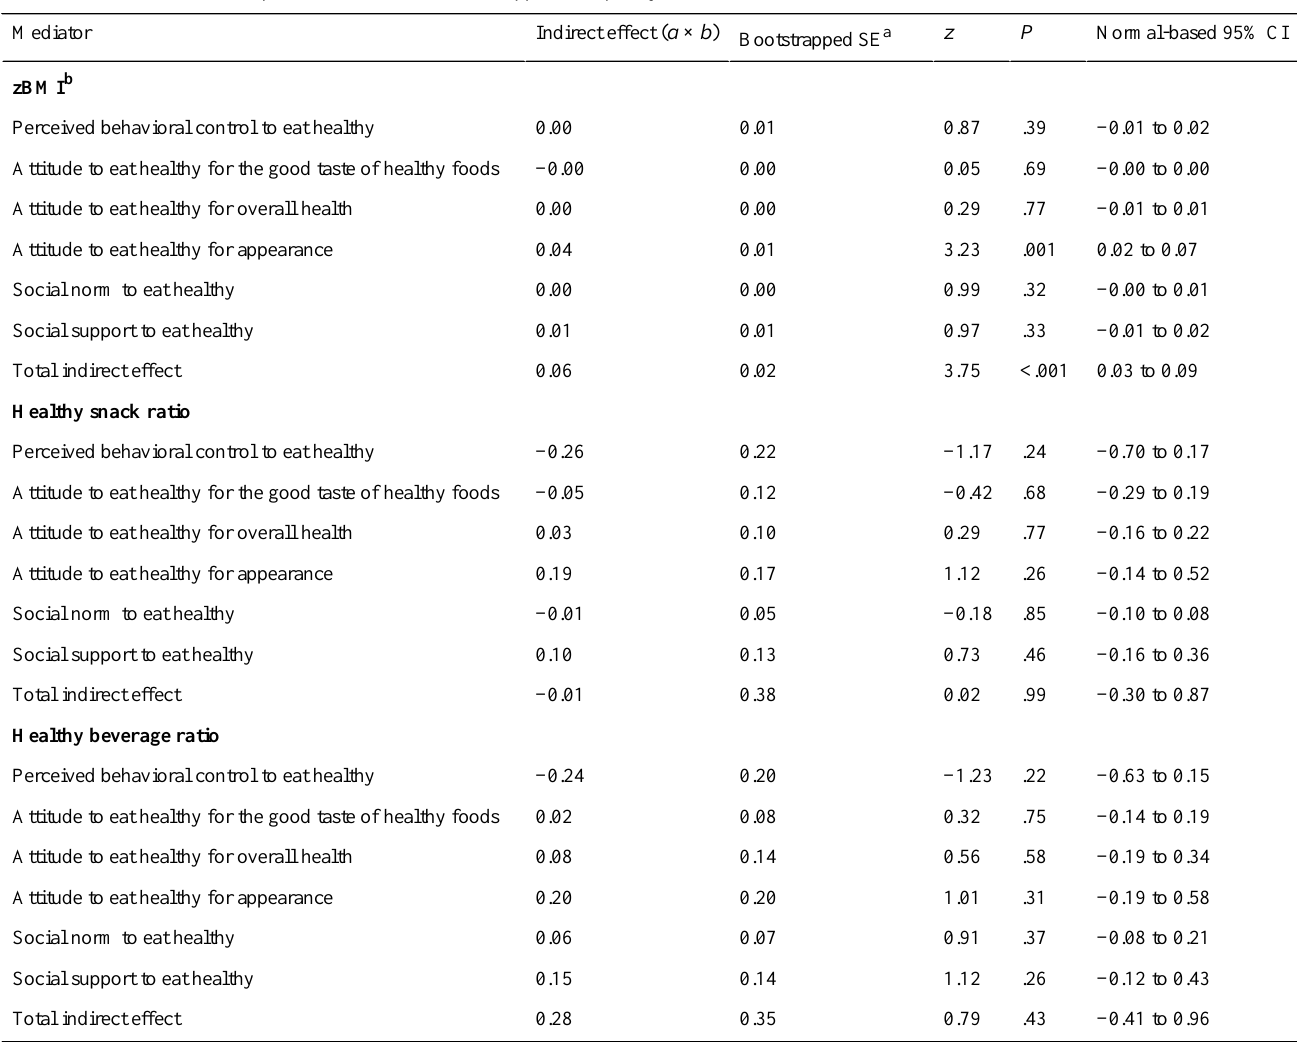
Table 4. Indirect effects multiple mediation with nutrition app use